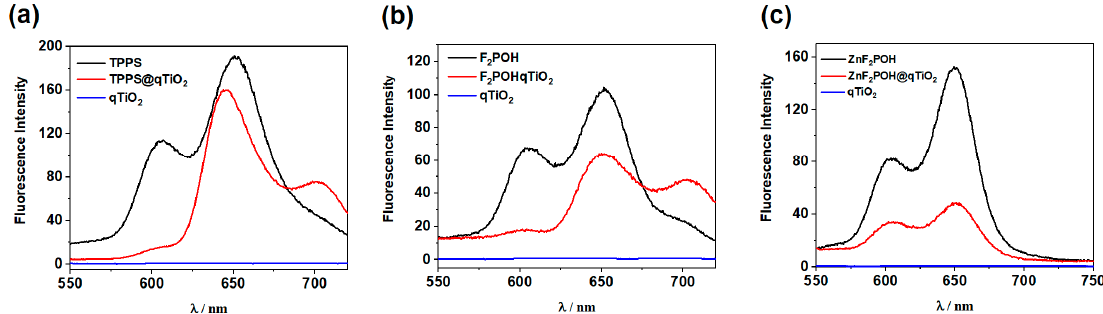
Figure 4. Fluorescence spectra of sulfonyl derivatives of porphyrins: ( a ) TPPS, ( b ) F 2 POH, ( c ) ZnF 2 POH, and relevant TiO 2 -based nanomaterials.